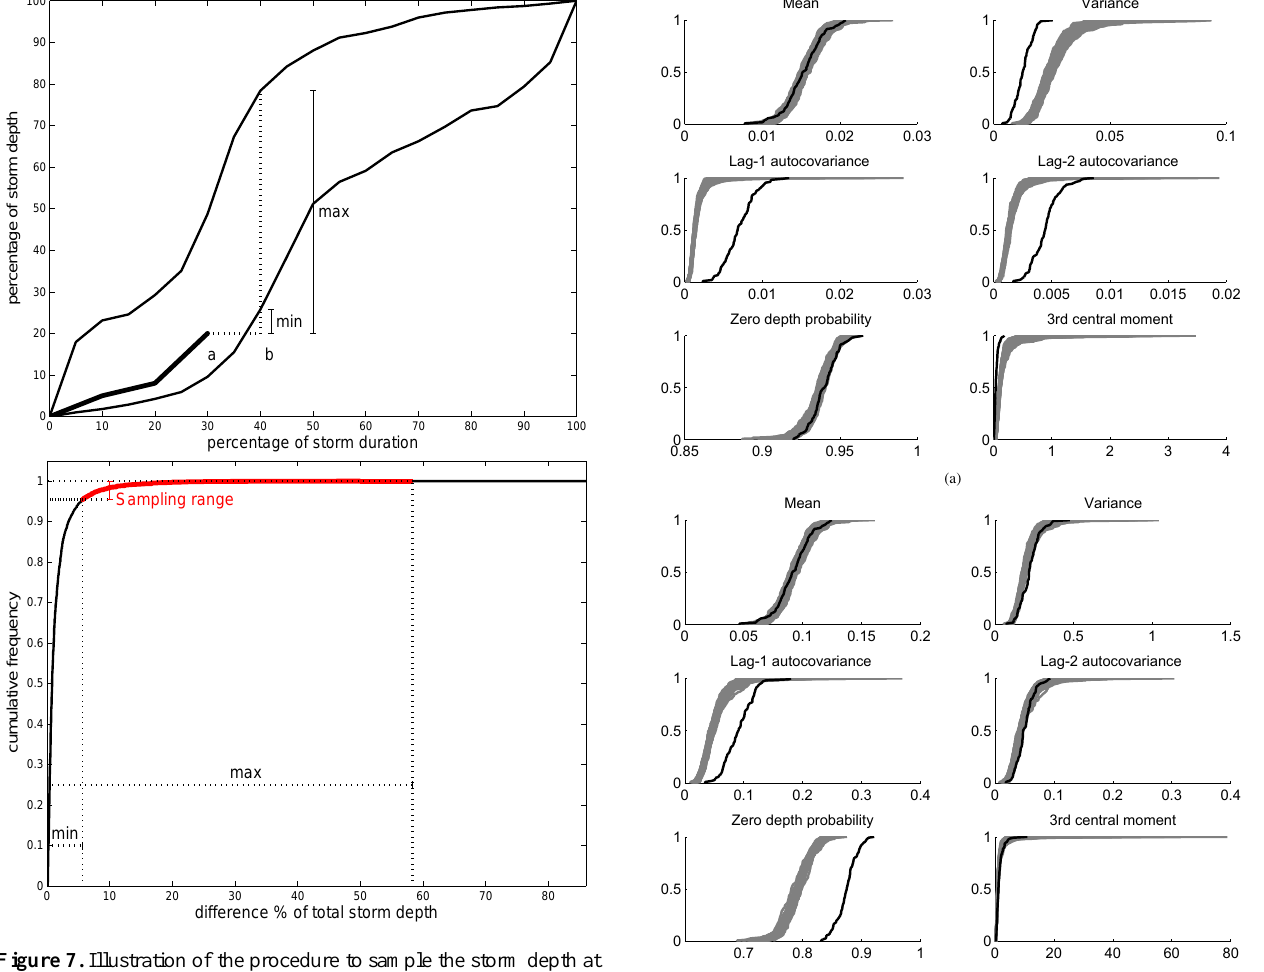
Figure 7. Illustration of the procedure to sample the storm depth at the next time instant (b). First, the minimal and maximal increment in percentage of storm depth at time instant b are determined (top panel). Then, the corresponding sampling range in the CDF of nor- malized increments is defined based on the minimal and maximal increment in percentage of storm depth derived from the top panel (bottom panel).